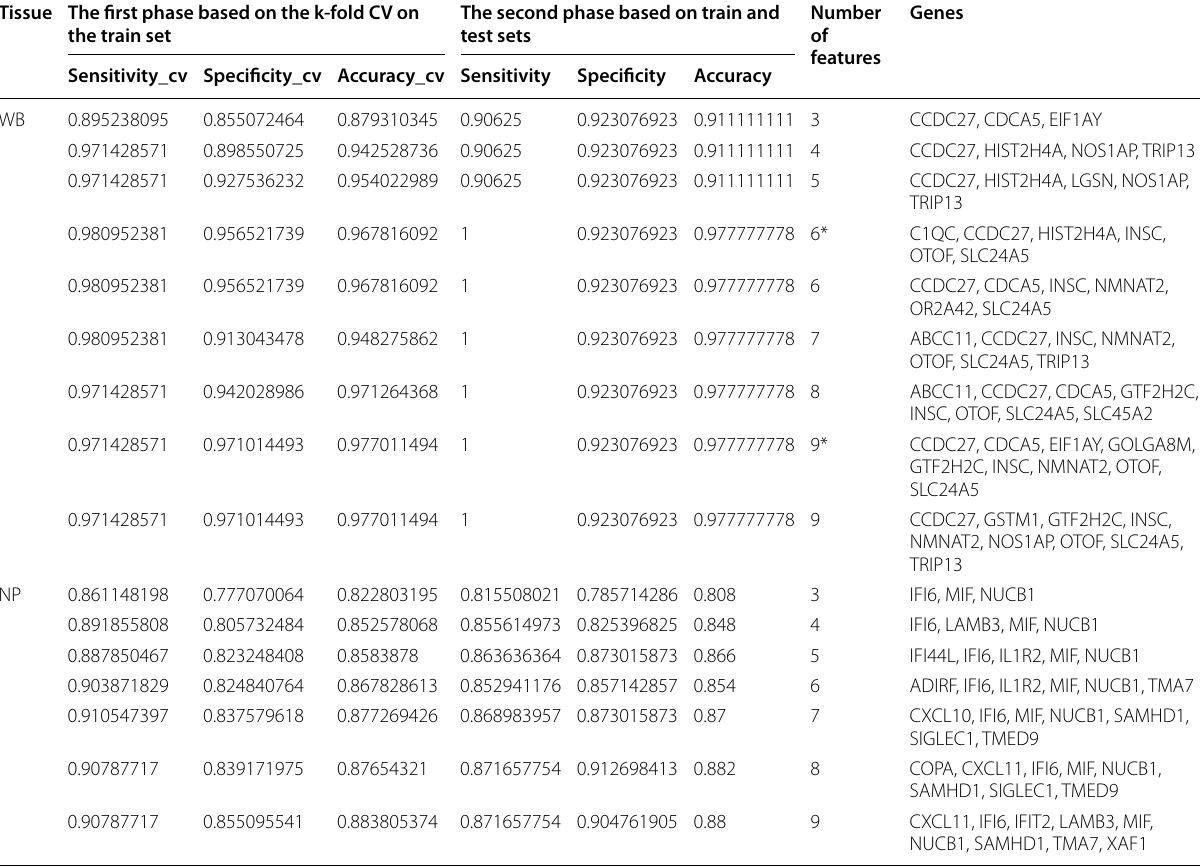
WB whole blood, NP nasopharyngeal *Selected to depict ROC curves